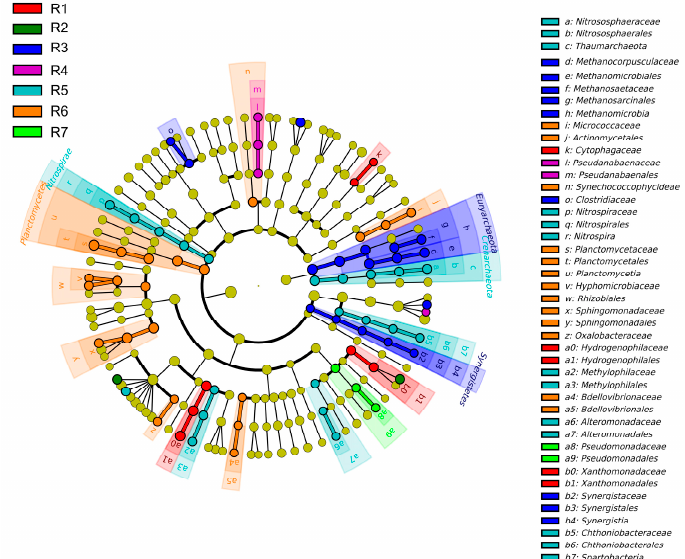
Figure 5. Taxonomic cladogram obtained from LEfSe analysis of 16S sequences. In the LEfSe tree, different colors indicate different groups. Each small circle with different colors represent a taxon, and the diameter of the small circle is proportional to the relative abundance. The yellow circles indicate non-significant differences in abundance among groups.